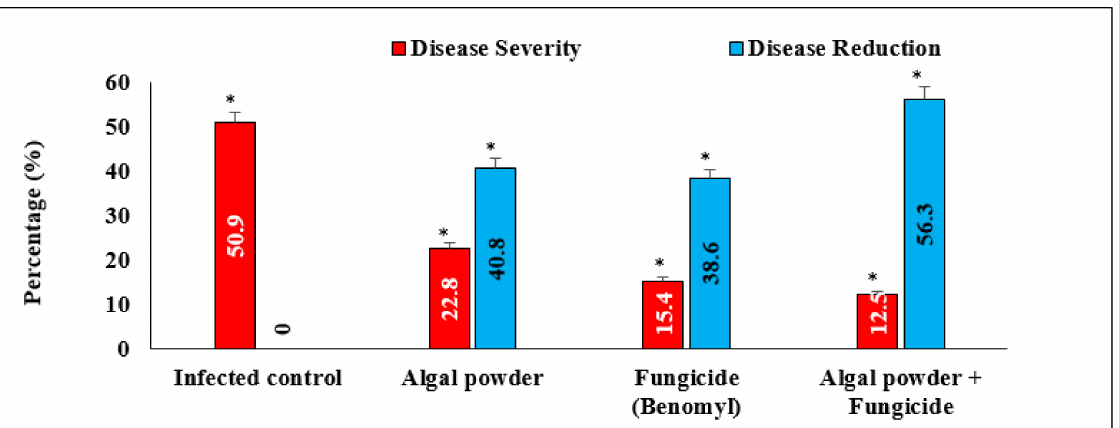
Figure 11. Disease severity of Fusarium wilt (percentage) in tomatoes treated with algal powder of S. dentifolium (at 10% concentration) (highly significant = * p < 0.05, n =